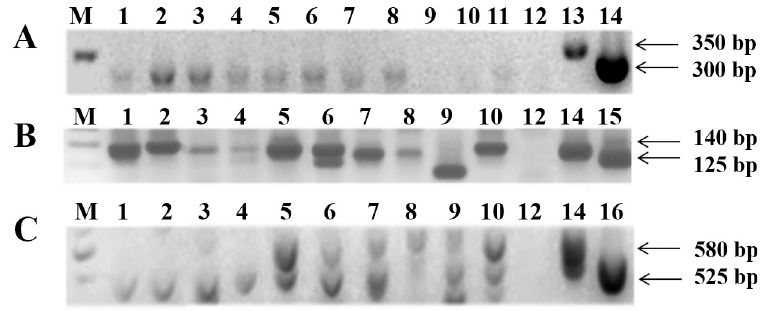
Fig 6. Multilocus conventional PCR for T . cruzi genotyping from patient blood samples. PCR product sizes (bp) are indicated on the right by arrows. In A, SL-IR I and II target. In B, 24S α (second round) target. In C, A-10 target. Lanes 1–11: patient samples. Lane 12: no template control (NTC), Lane 13: Dm28c clone (TcI), Lane 14: Y strain (TcII), Lane 15: INPA 3663 strain (TcIII), Lane 16: CL strain (TcVI). M: 50 or 100 bp DNA